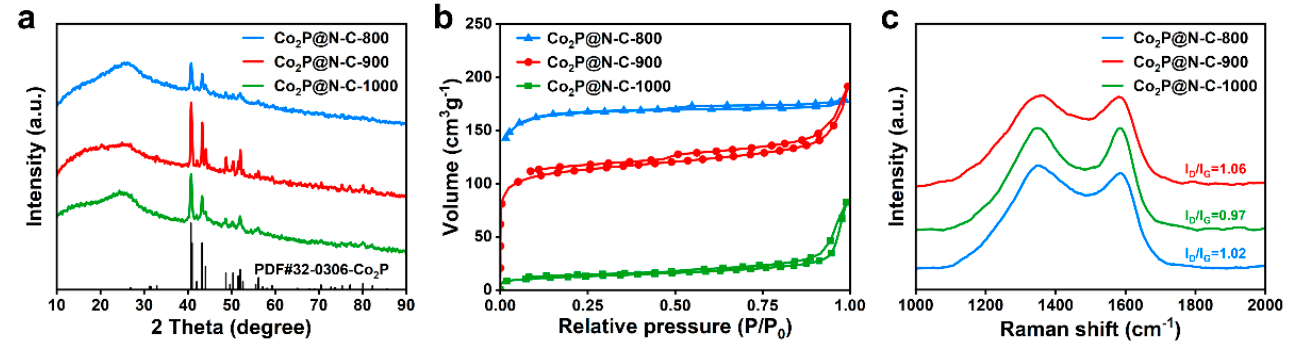
Figure 3. ( a ) XRD spectra of samples calcined at different temperatures. ( b ) Nitrogen (N 2 ) adsorption/desorption isotherm of Co 2 P@N-C-800, Co 2 P@N-C-900 and Co 2 P@N-C-1000. ( c ) Raman spec- troscopy of Co 2 P@N-C-800, Co 2 P@N-C-900 and Co 2 P@N-C-1000.